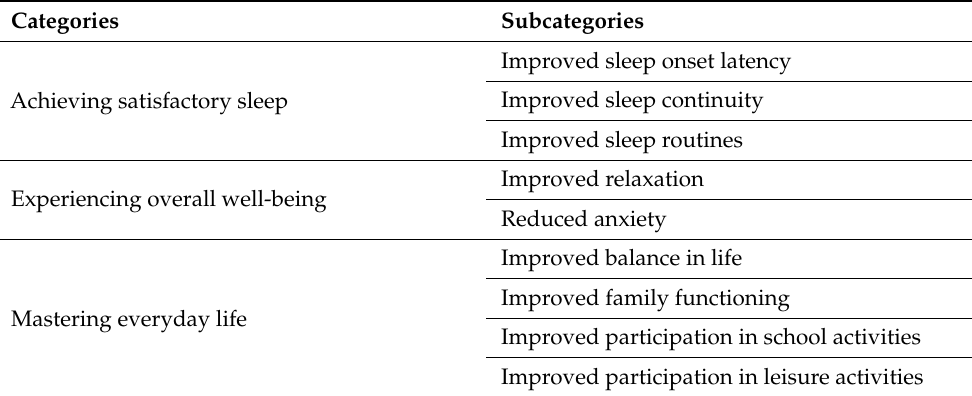
Table 2. Overview of the categories and subcategories showing parents’ experiences of the weighted blankets’ impact on children with